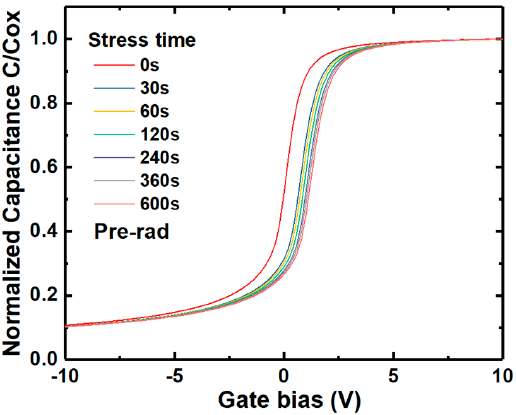
Figure 21. HF C-V characteristics of the un-irradiated samples with the stress time.